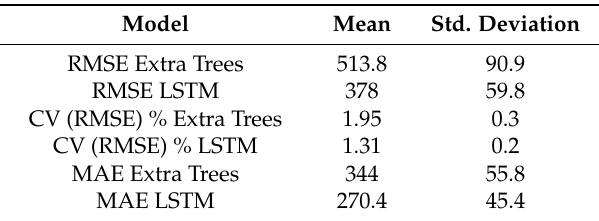
Table 5. Performance Metrics of LSTM-RNN and Extra Tree Regressor Model using the Cross Validation Approach.